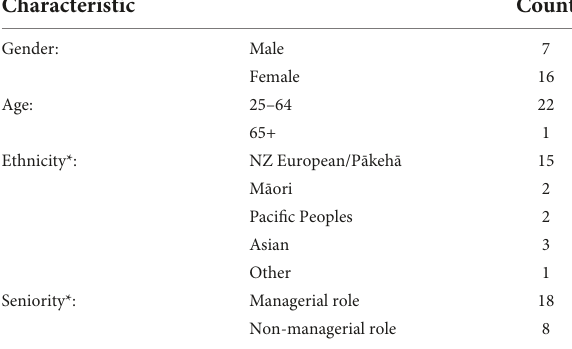
TABLE 1 Qualitative participants characteristics ( N =